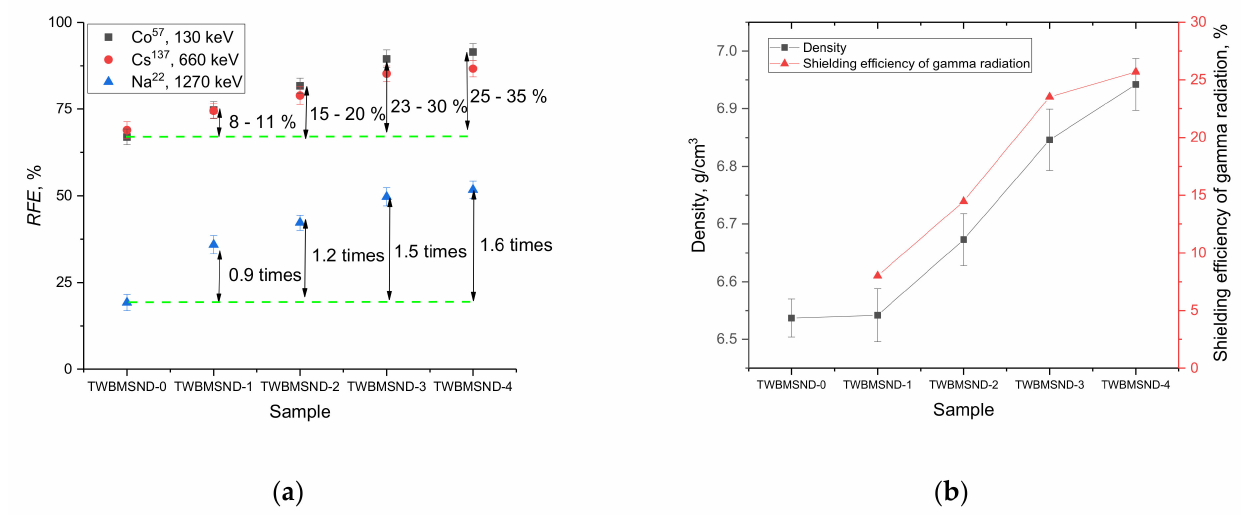
Figure 8. ( a ) Results of evaluation of the efficiency of shielding gamma radiation with different energies; ( b ) Comparison of the change in the density of glasses with the increase in the efficiency of shielding of gamma rays with an energy of 660